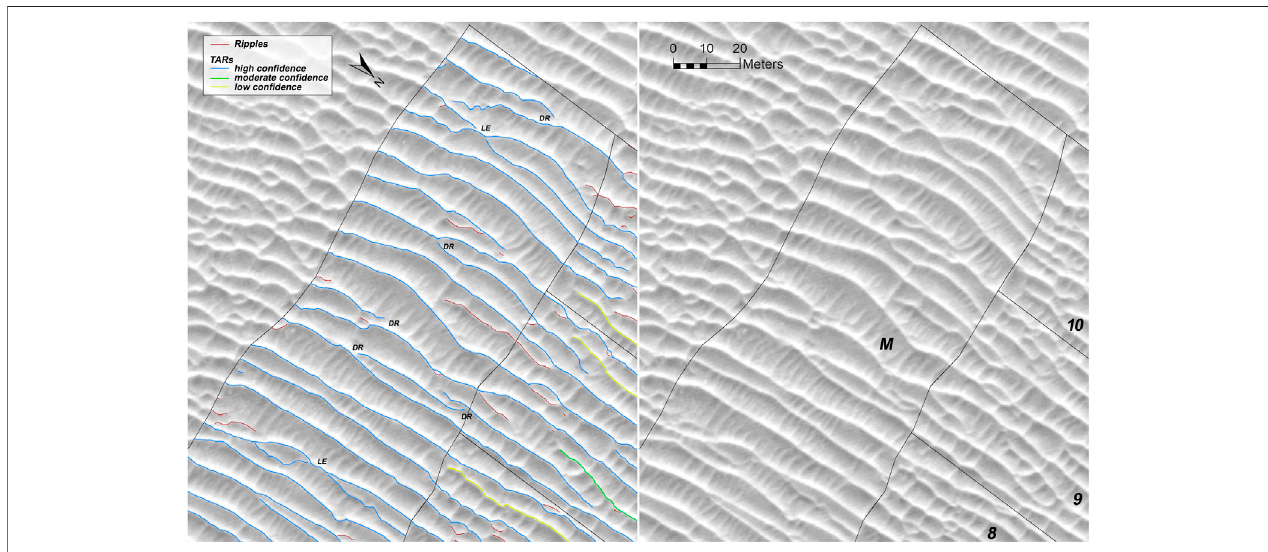
FIGURE 7 | TAR interactions in the mature pattern, shown with and without mapped crestlines (orthorecti fi ed HiRISE image ESP_044722_2570). Identi fi ed interactions are defect repulsion (DR) and possible lobe extensions (LE). Numbers correspond with wake segments, and the mature region is labeled M.